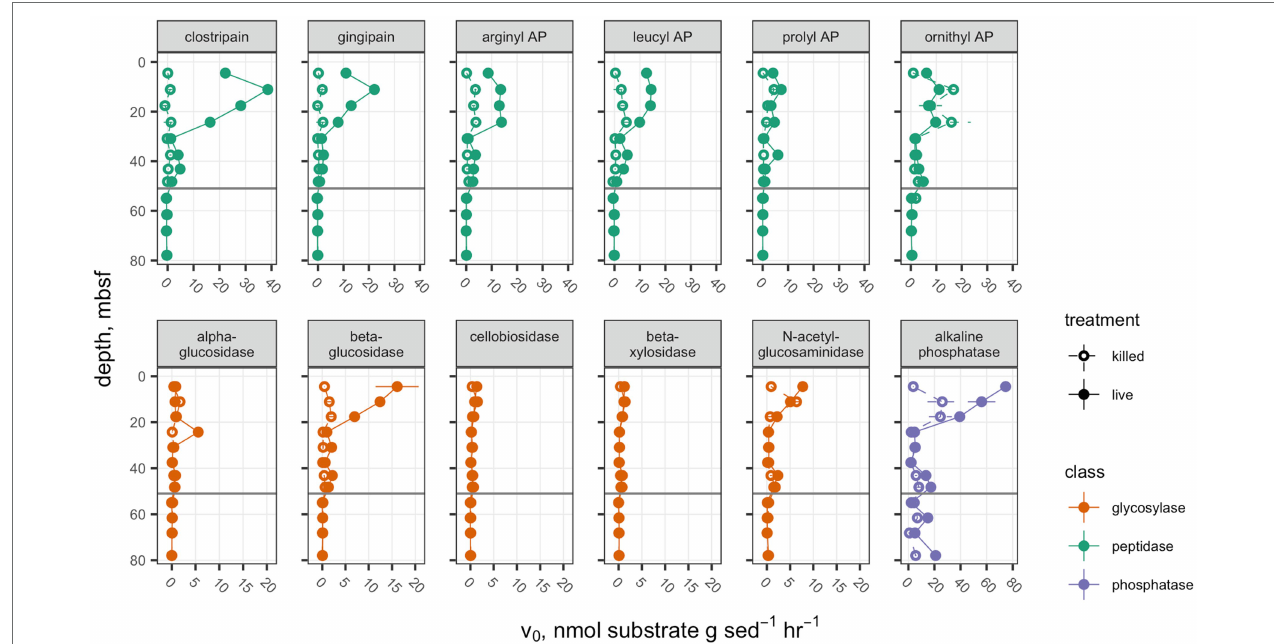
FIGURE 1 | Potential enzyme activities in hole M0059C as a function of depth. Live sample v 0 data for clostripain, gingipain, arginyl AP, leucyl AP, prolyl AP, α -glucosidase, β -glucosidase, N-acetyl- β - d -glucosaminidase, and β - d -xylosidase were previously presented in Bird et al. (2018). Open circles indicate autoclaved killed controls; filled circles indicate live samples. Note that each enzyme class shares a common scale, but scales differ between enzyme classes. Error bars represent one standard deviation about the mean for triplicate measurements. In cases where the error bars are not visible, they are smaller than the